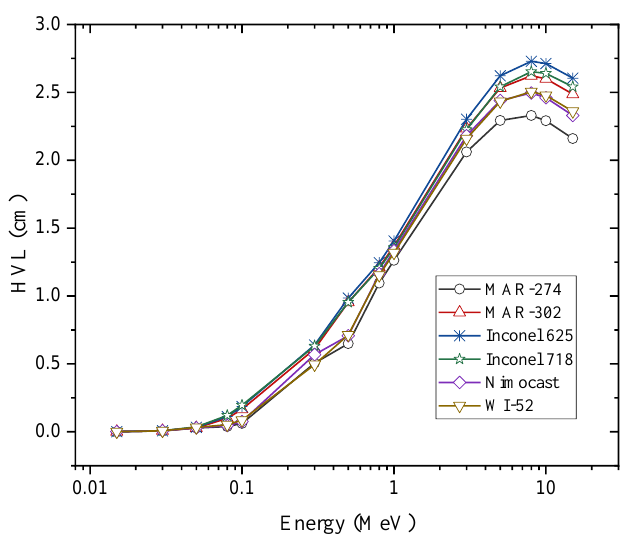
Figure 3. Variation of the half-value layer (HVL) of the studied alloys against the incident gamma-ray energy. The mean free path (MFP) of the investigated alloys was calculated based on the simulated MAC values for a gamma-ray energy range of 0.015–15 MeV. The variation of the MFP versus the gamma photon energies for all selected alloys is shown in Figure 4. The variation of the MFP versus the gamma photon energies is similar to the variation of HVL discussed previously. The lowest MFP was obtained for the MAR-247 alloy and varied between 0.001 and 3.361 cm, while the highest MFP was achieved for the alloy encoded as Inconel-625 and varied between 0.002 and 3.936 cm. Moreover, the MFP of the studied alloys were compared with other common radiation shielding materials in Figure 4: ordinary concrete, commercial glass RS-253 G18, and lead at some fixed energies (0.5, 1, 5, and 15 MeV). The MFP of the studied alloys was lower than the MFP of ordinary concrete and commercial glass RS-253 G18. In contrast, the MFP of the studied alloys was higher than the MFP of Pb, with the MFP for lead varying between 0.0546 and 1.557 cm for gamma photon energies between 0.5 and 15 MeV, respectively.